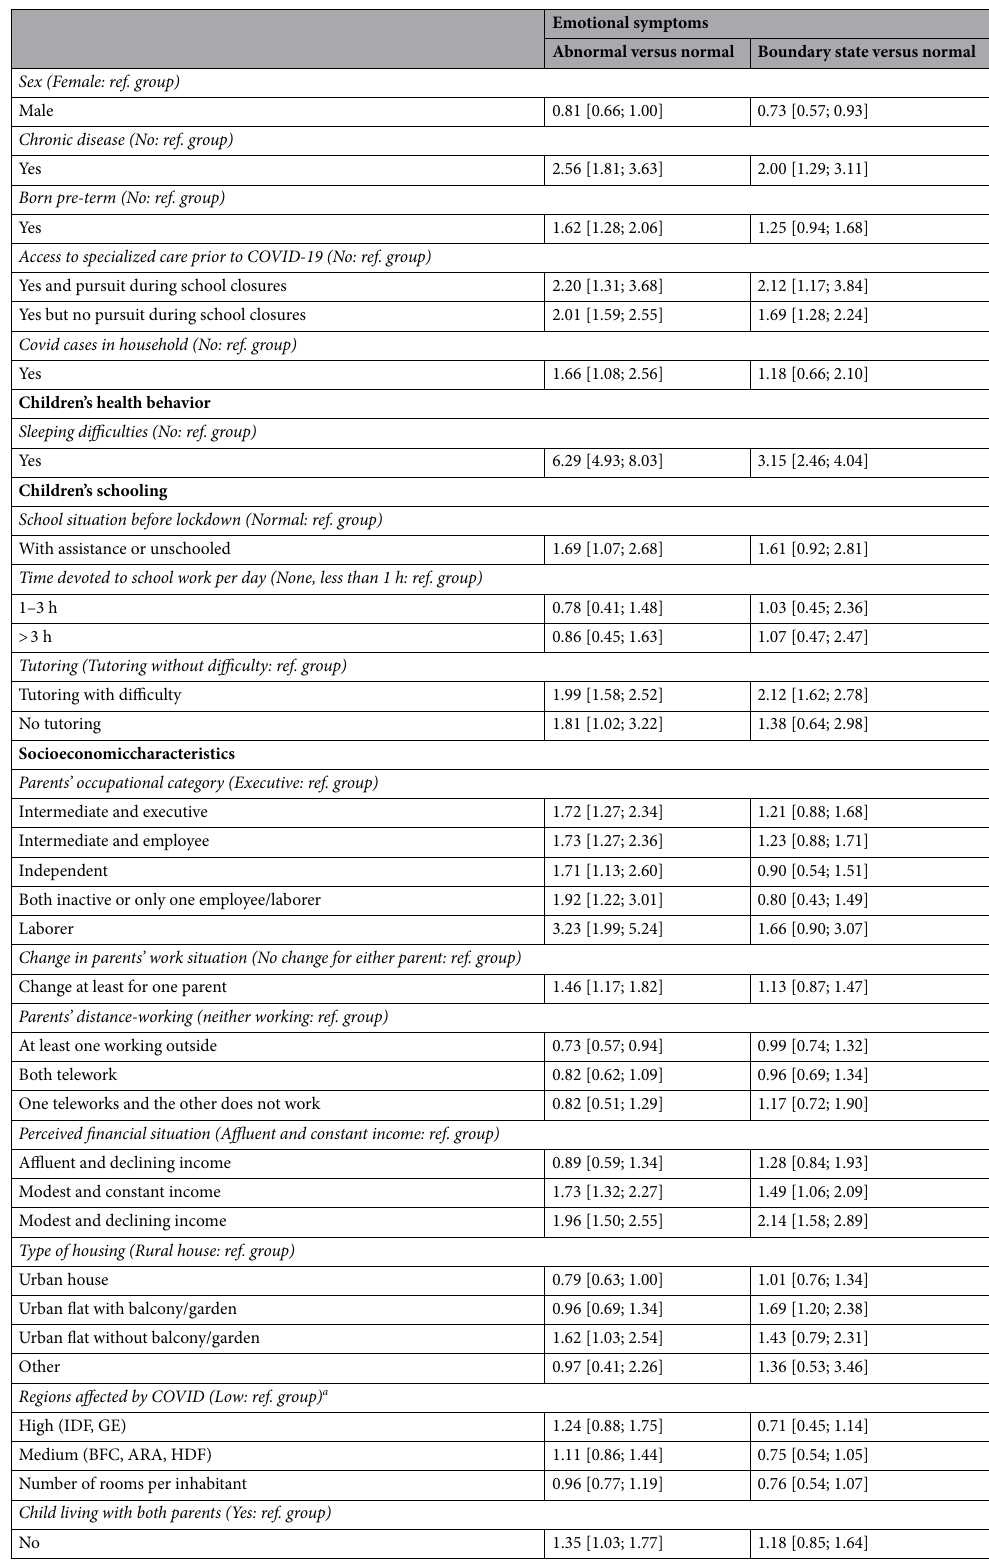
Table 4. Factors associated with emotional symptoms: multinomial logistic regressions adjusted on prematurity (n = 5097). a Region classified according to prevalence of COVID-19 at beginning of epidemic (High: Ile de France and Grand Est vs Medium: Bourgogne-Franche-Comté, Auvergne-Rhône-Alpes and Hauts-de-France vs Low: other